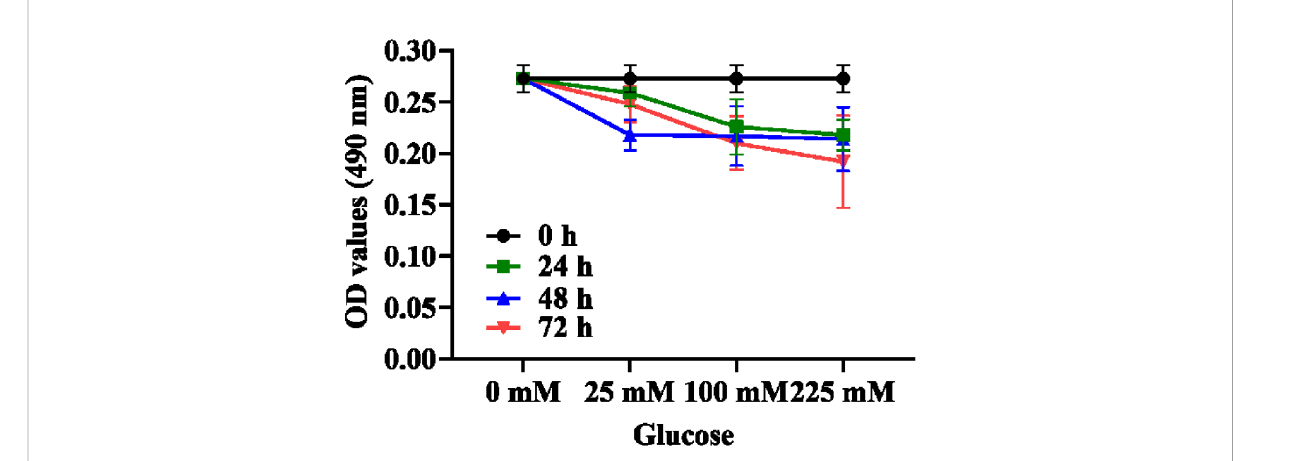
FIGURE 4 Comparison of cell viability of hippocampal neurons under high glucose